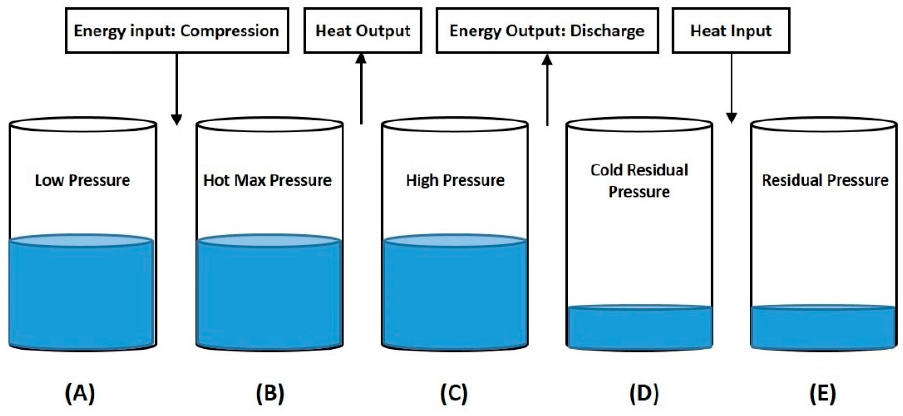
Figure 2. State of the high-pressure tank during the process of charging and